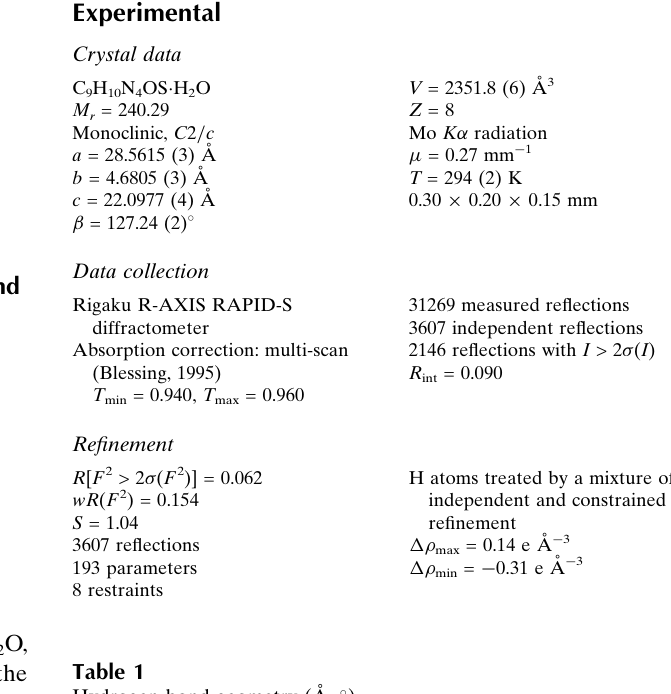
Hydrogen-bond geometry (A˚ , (cid:2) ). D —H (cid:1)(cid:1)(cid:1)